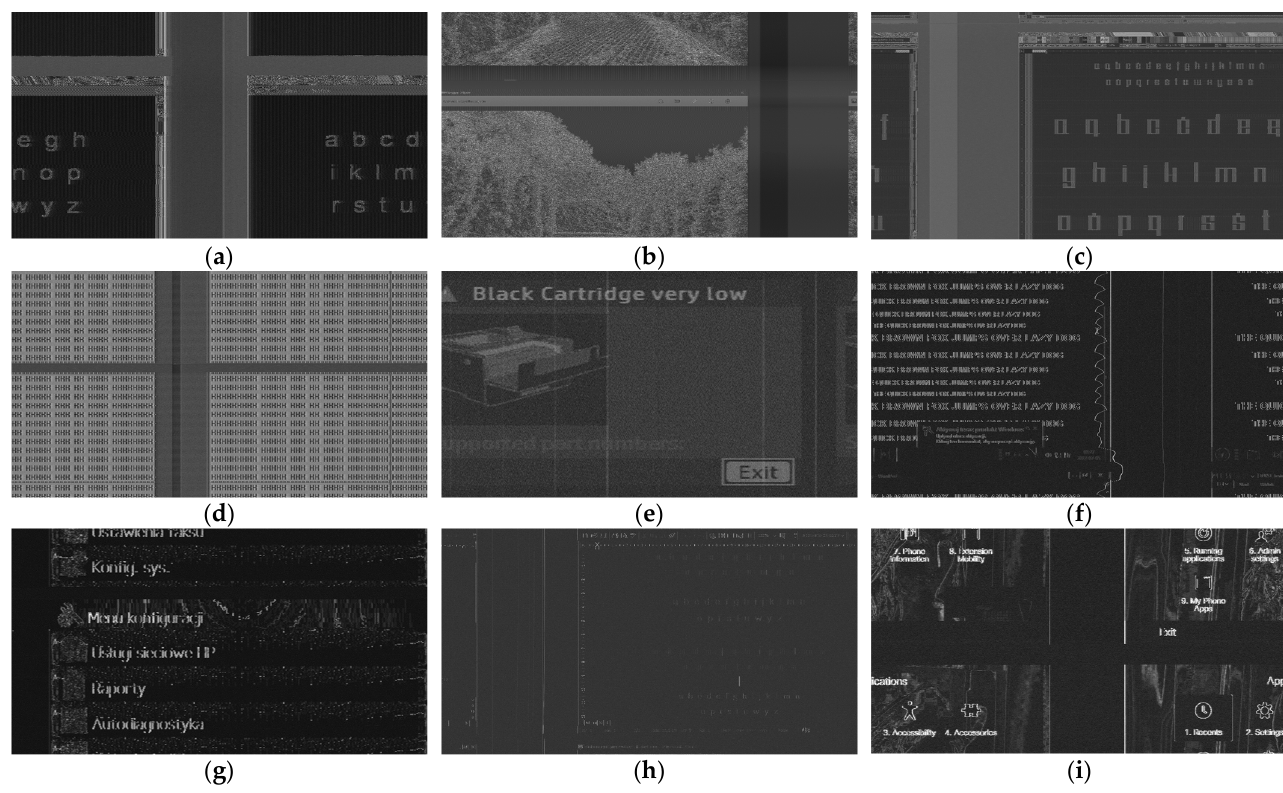
Figure 19. Images for which statistical analyses were conducted (images reconstructed on base on reveal emissions for thirty times summation without colorization): ( a ) DVI standard, receive frequency f o = 365 MHz, BW = 50 MHz, number lines B corr = 525, resolution 640 × 480/60 Hz; ( b ) DVI standard, receive frequency f o = 1334 MHz, BW = 50 MHz, number lines B corr = 1066, resolution 1280 × 1024/60 Hz; ( c ) DVI standard, receive frequency f o = 1805 MHz, BW = 100 MHz, number lines B corr = 1066, resolution 1280 × 1024/60 Hz; ( d ) DVI standard, receive frequency f o = 1775 MHz, BW = 100 MHz, number lines B corr = 1125, resolution 1920 × 1080/60 Hz; ( e ) laser printer HP M507, menu with icons, receive frequency f o = 392 MHz, BW = 10 MHz, number lines B corr = 266; ( f ) VGA standard, receive frequency f o = 450 MHz, BW = 20 MHz, number lines B corr = 628, resolution 800 × 600/60 Hz; ( g ) laser printer, menu with text, receive frequency f o = 235 MHz, BW = 10 MHz, number lines B corr = 288; ( h ) DVI standard, receive frequency f o = 740 MHz, BW = 50 MHz, number lines B corr = 628, resolution 1280 × 1024/60 Hz; and ( i ) display of terminal VoIP, receive frequency f o = 800 MHz, BW = 20 MHz, number lines B corr =